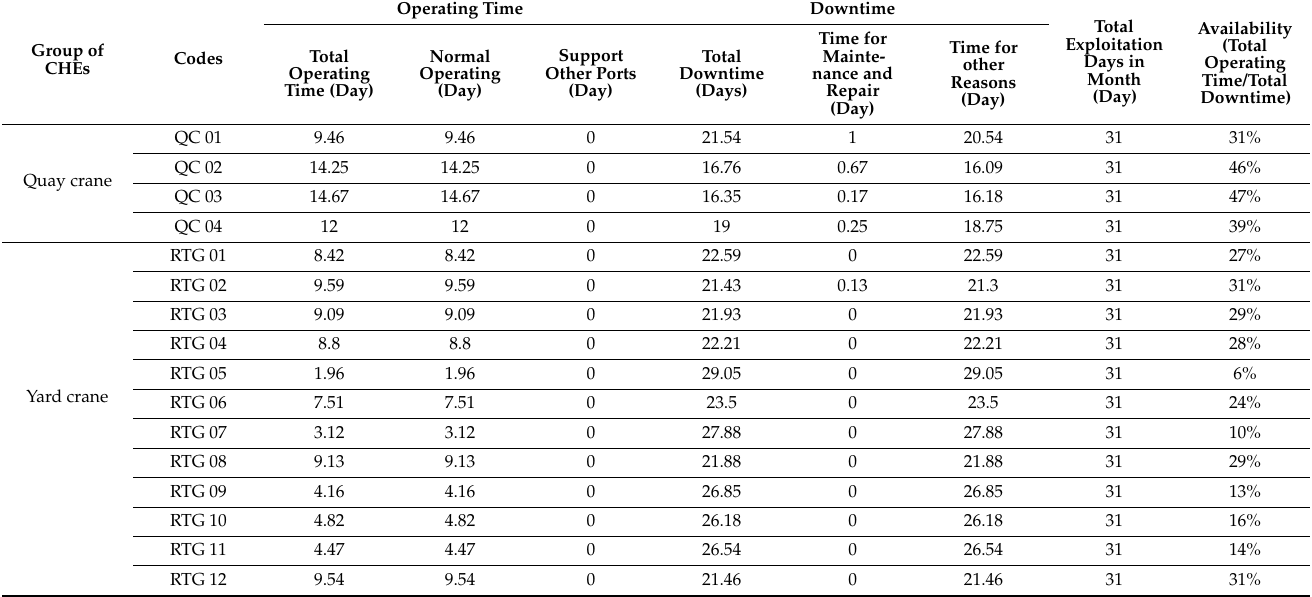
Table 6. The availability of quay cranes (QC) and yard cranes (RTG) in December 2021 at Nam Dinh Vu